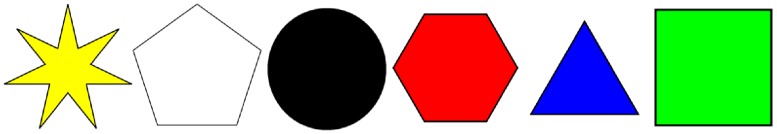
The shapes used for the rating and betting experiments.